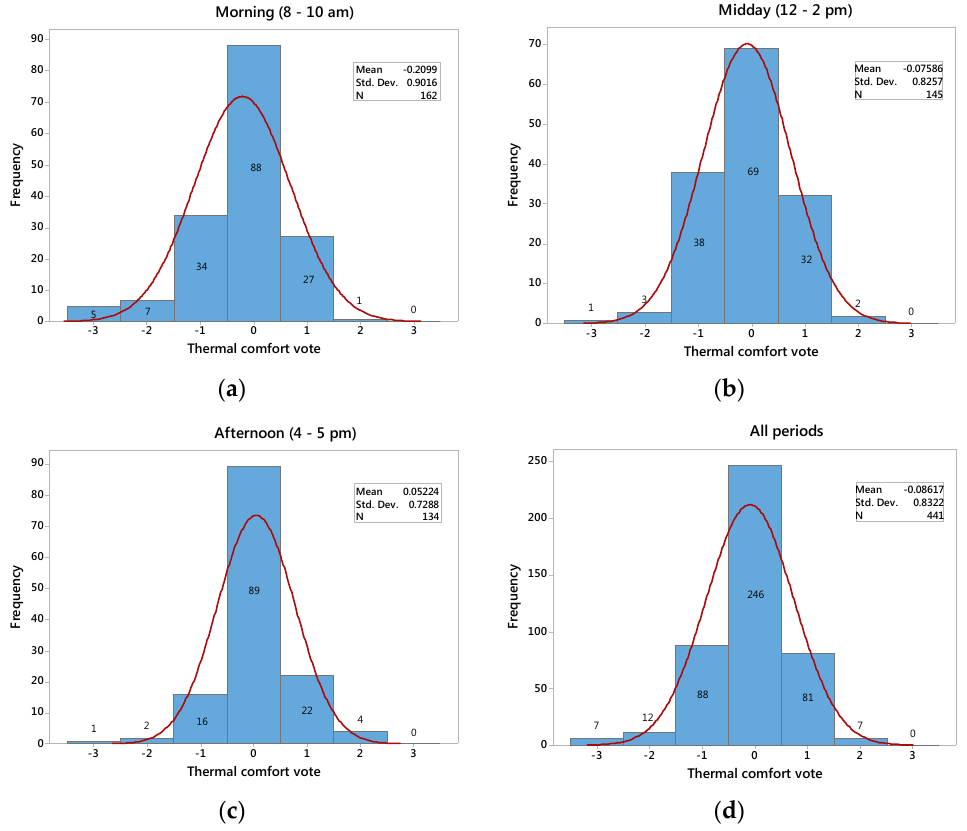
Figure 7. Histograms of thermal sensation votes on ASHRAE’S seven-point scale (AMV from surveys): ( a ) Thermal sensation votes in the morning; ( b ) thermal sensation votes in the midday; ( c ) thermal sensation votes in the afternoon; ( d ) thermal sensation votes during the experimental campaign.